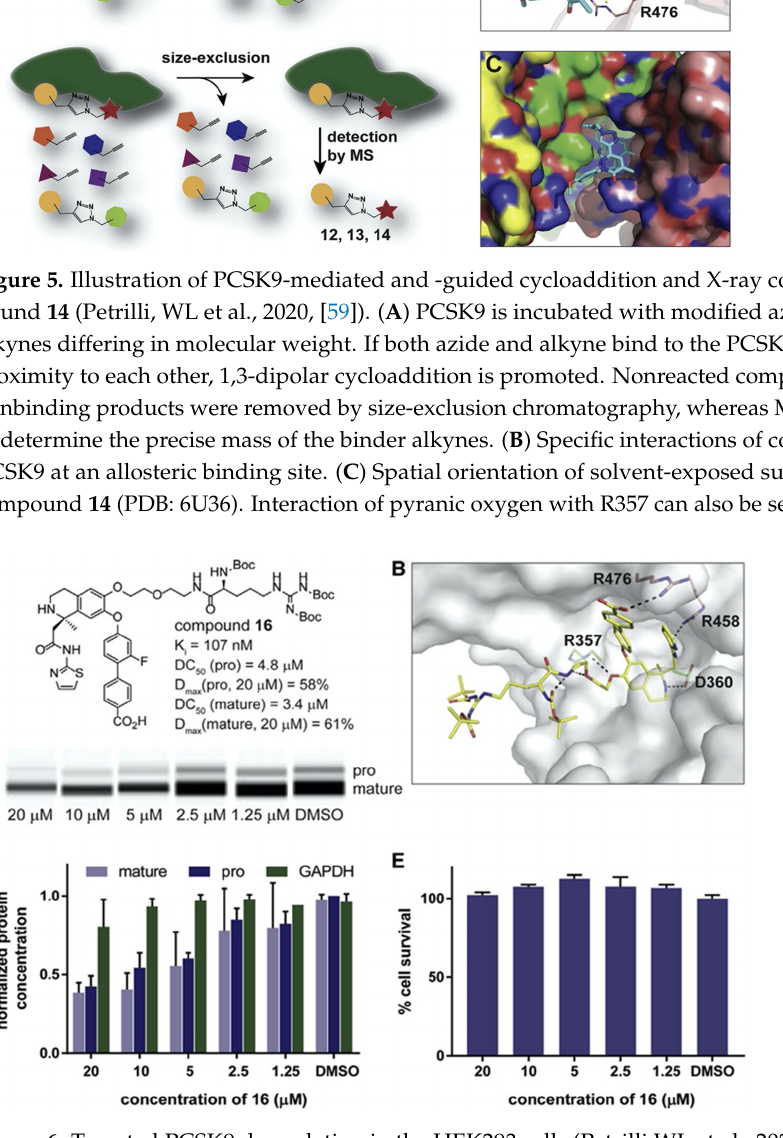
Figure 6. Targeted PCSK9 degradation in the HEK293 cells (Petrilli WL et al., 2020) [59]. ( A ) Com- pound 16 and its binding to PCSK9. ( B ) Crystal structure of compound 16 bound to PCSK9 (PDB: 6U26). ( C ) Western blot analysis of pro-PCSK9 and mature PCSK9 after 24 h of incubation with compound 16 in 1.25–20 mM of HEK293 cells, overexpressing PCSK9. ( D ) Analysis of overall PCSK9 and GAPDH levels after 48 h incubation with compound 16 in 1.25–20 mM of HEK293 cells, over- expressing PCSK9. The error bars denote SD. ( E ) Cell viability analysis (CellTiter-Glo) after 48 h incubation of HEK293 cells with 1.25–20 м M of compound 16 . Error bars denote SD.